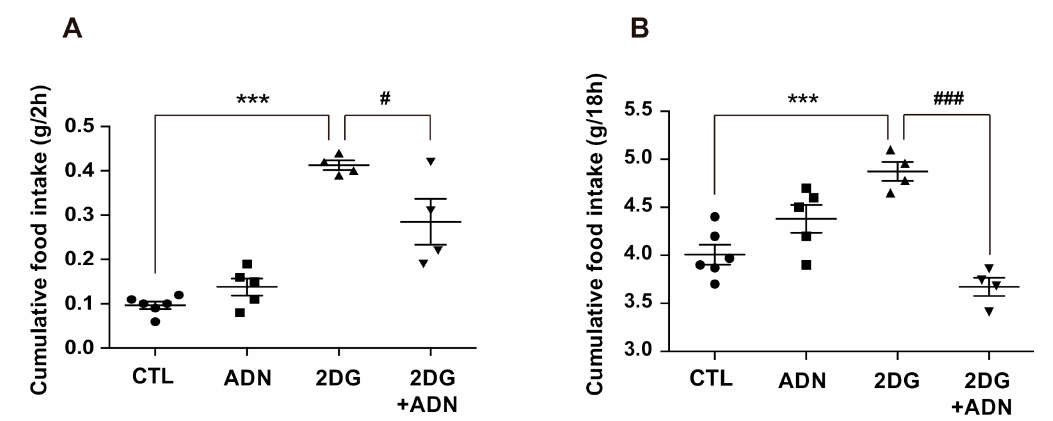
Figure 6. Central administration of adiponectin reversed increased food intake in response to icv injection of 2-DG. Icv injection of adiponectin curbed the increase of ( A ) 2 h and ( B ) 18 h cumulative food intake induced by icv injection of 2-DG. Results are presented as the mean ± SEM. n = 4–6 for each group. *** p < 0.001 for the 2-DG-treated versus the CTL groups; # p < 0.05, ### p <0.001 for the 2-DG + ADN-treated versus 2-DG-treated